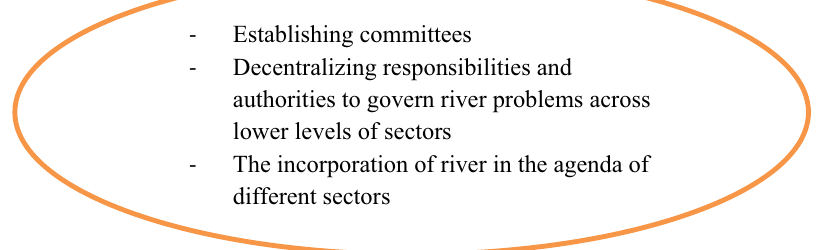
Fig. 1 A conceptual framework that shows how cross-sectoral collaborations in the collective governance of Addis Ababa Rivers are influenced and challenged. Source Compiled by the Researcher Based on Review of